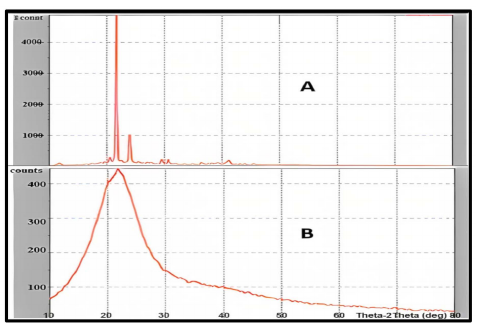
Figure 8. Powder X-ray diffraction studies of pure curcumin ( A ), and curcumin NLCs-F1 ( B ) presenting significant lowering intensity due to high amorphization, the plot of Counts vs. Theta-2 Theta